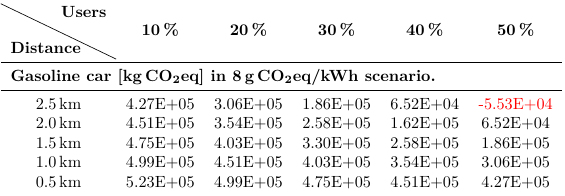
Table 2. In the table above, the results for the refurbishment scenario for the first 30 years presented. The emissions from transportation to and from the school are only higher (see red marking) than the embodied and operational emissions from the building if half of the children go by car over a distance of 2.5 km or greater.